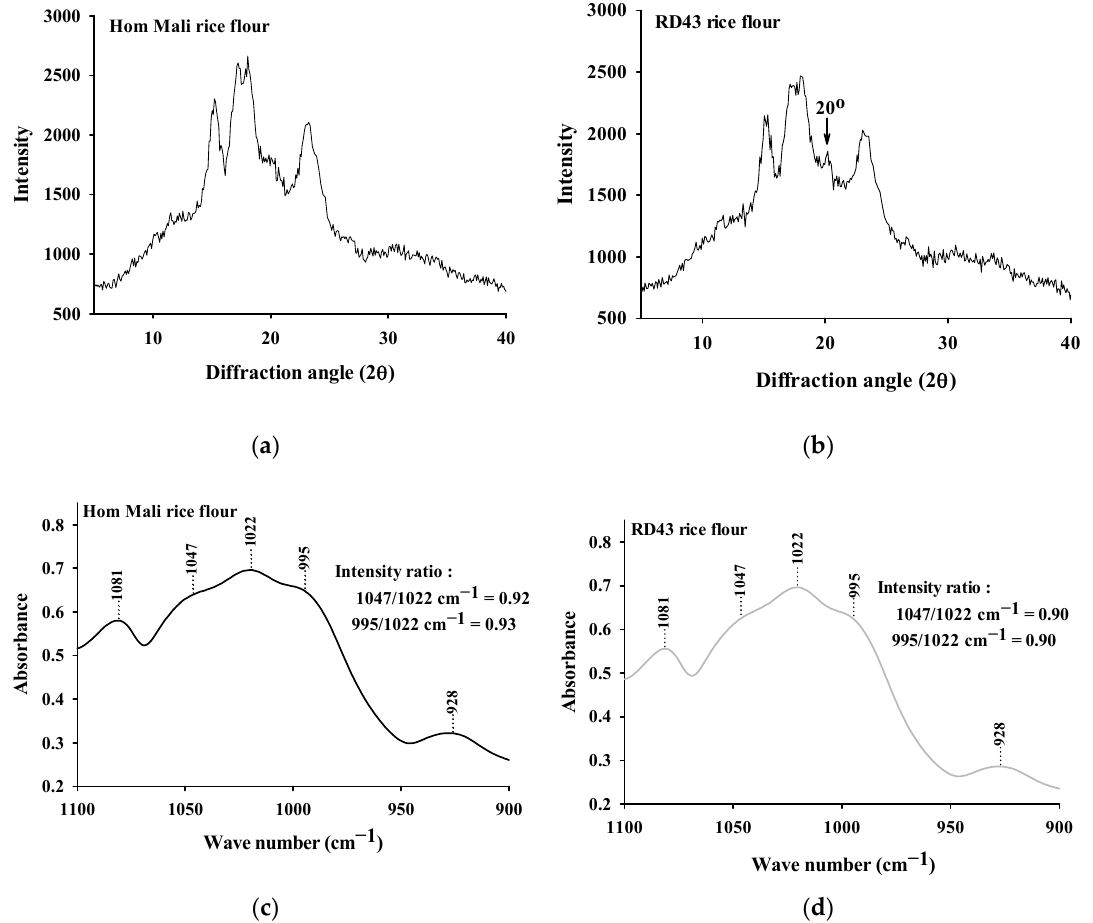
Figure 3. X-ray diffraction pattern of ( a ) Hom Mali and ( b ) RD43 rice flour. Fourier transform infrared (FTIR) spectra of ( c ) Hom Mali and ( d ) RD43 rice flour .